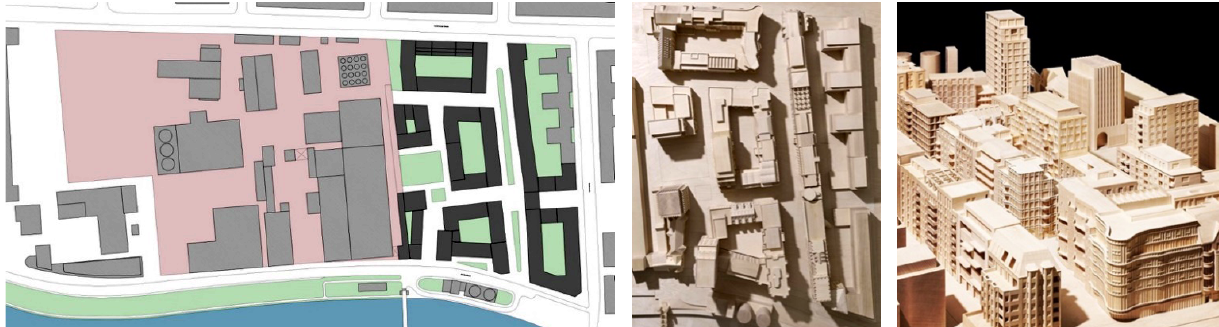
Figure 21. WerkbundStadt am Spreebord in Berlin. From left to right: masterplan; models. Source: Kahlfeldt (2016).